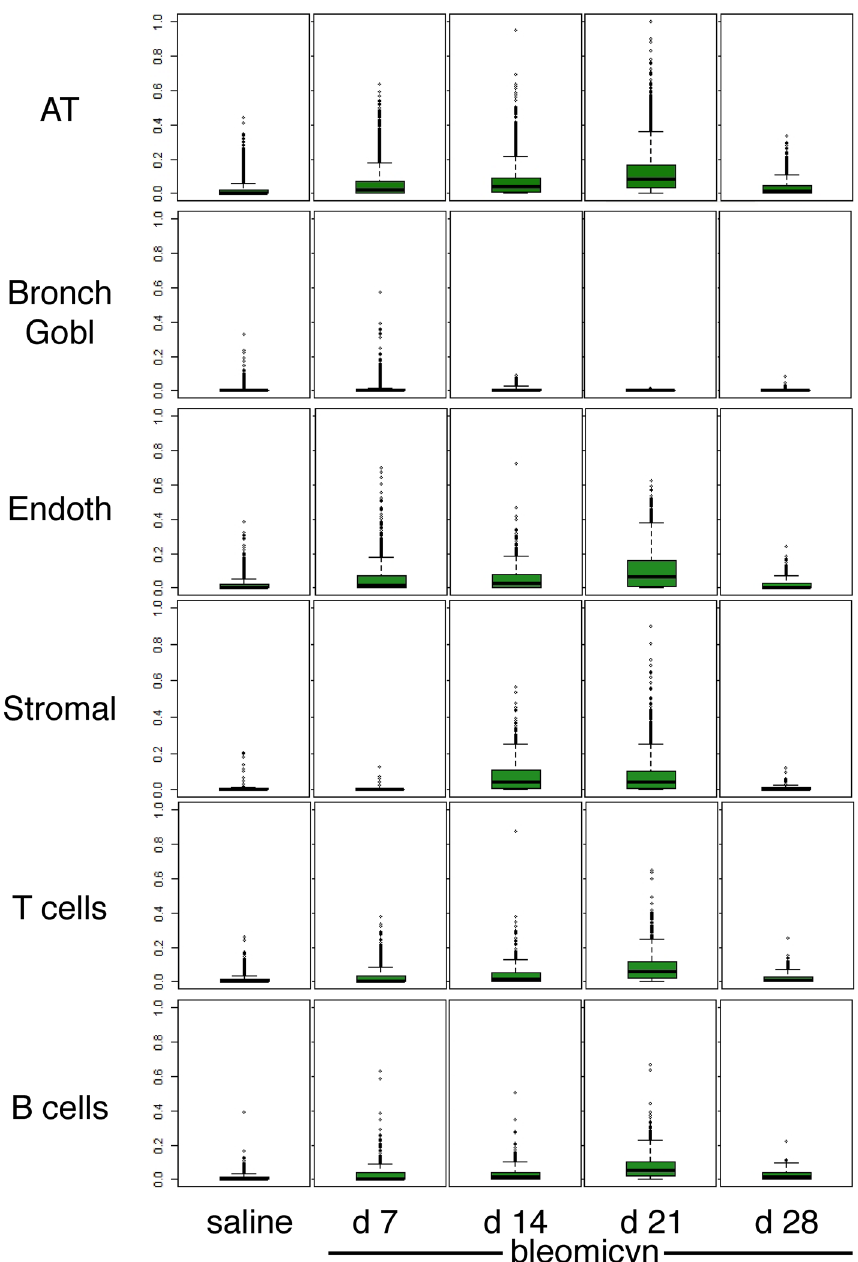
Figure 5. Multidrug transporter (P-gP) levels during Bleomycin treatment in selected cell types. The linear fluorescence levels (0–255), rescaled 0–1 of the multidrug transporter from all experimental animals are plotted as boxplots and outliers for each treatment group and for the selected cell types. AT = all alveolar epithelial cells; Bronch Gobl = bronchial cells and MUC5B + cells